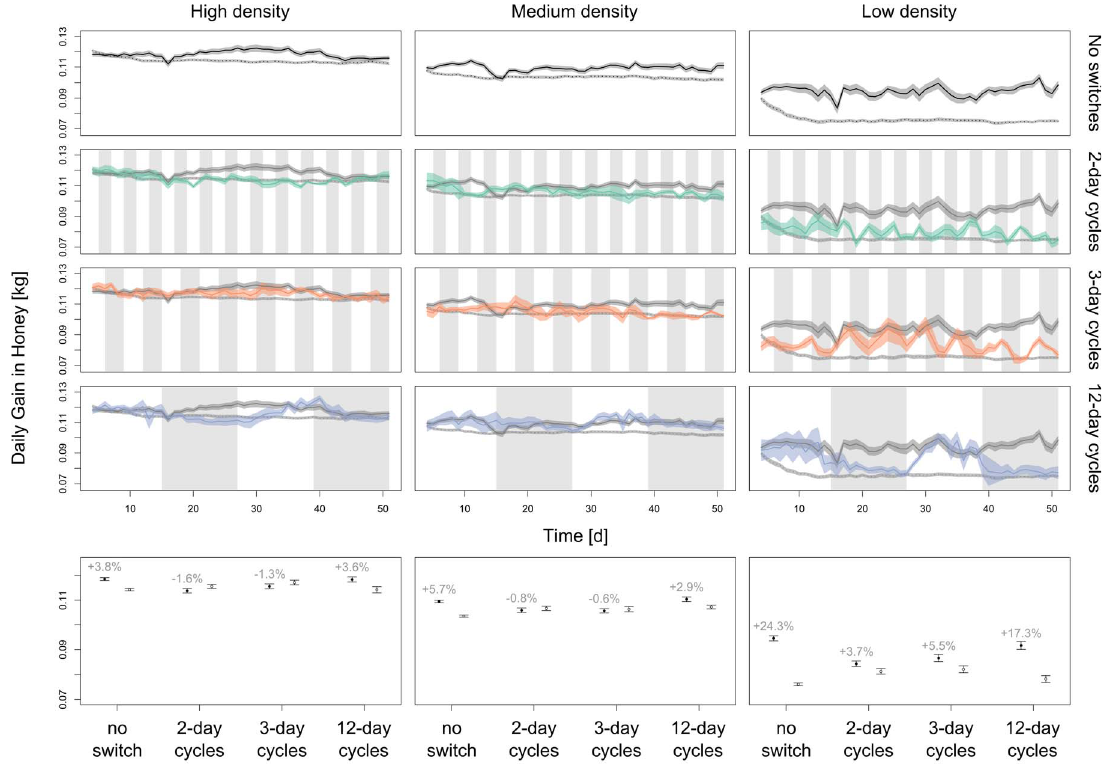
Figure 1. A comparison of foraging success measured as daily gain in honey under high, medium and low food densities, either with spatial information transfer (SI) or without spatial information transfer (NI). Model runs lasted 48 days after an initial period of 3 days SI (the 3 day acclimatization period is not shown). The first row shows the pure SI (solid black line) and NI (dotted black line) cases. These baselines are also shown for the model runs where switching between SI and NI occurred (rows 2–4, black solid and dotted lines). Rows 2–4 show the cases for SI (white background)/NI (grey background) cycles that last 2 days, 3 days or 12 days respectively. All the simulations shown here started with the SI treatment on day 4. The last row shows the aggregated simulation results (means 6 s.e.) for the three food densities and SI/NI cycles (solid circles: SI, open circles: NI) including the second set of simulations that started with the NI treatment on day 4.